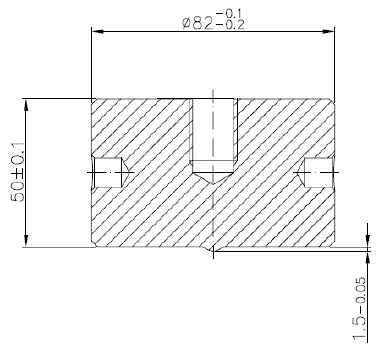
Figure 3. View of the schematic of the punch.